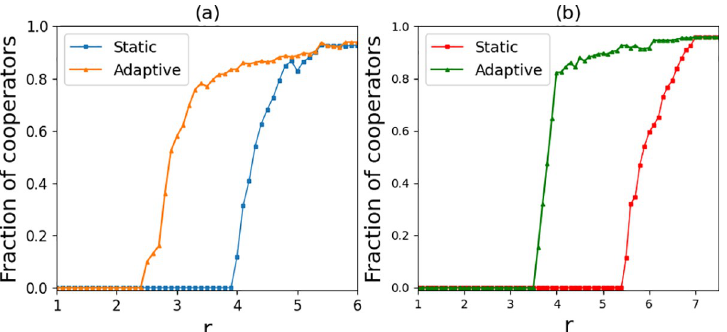
Fig 4. Fraction of cooperators as a function of the synergy factor r for coevolution adaptive network and static regular network. (a) Average degree of network ^ k ¼ 4 ; (b) average degree ^ k ¼ 6 . Under two average degrees, cooperative behavior emerges earlier with the partner switching mechanism than in a static network. Parameters: N = 10000, t = 10000, T = 20 , α = 5, β = 5, and ω = 0.1.